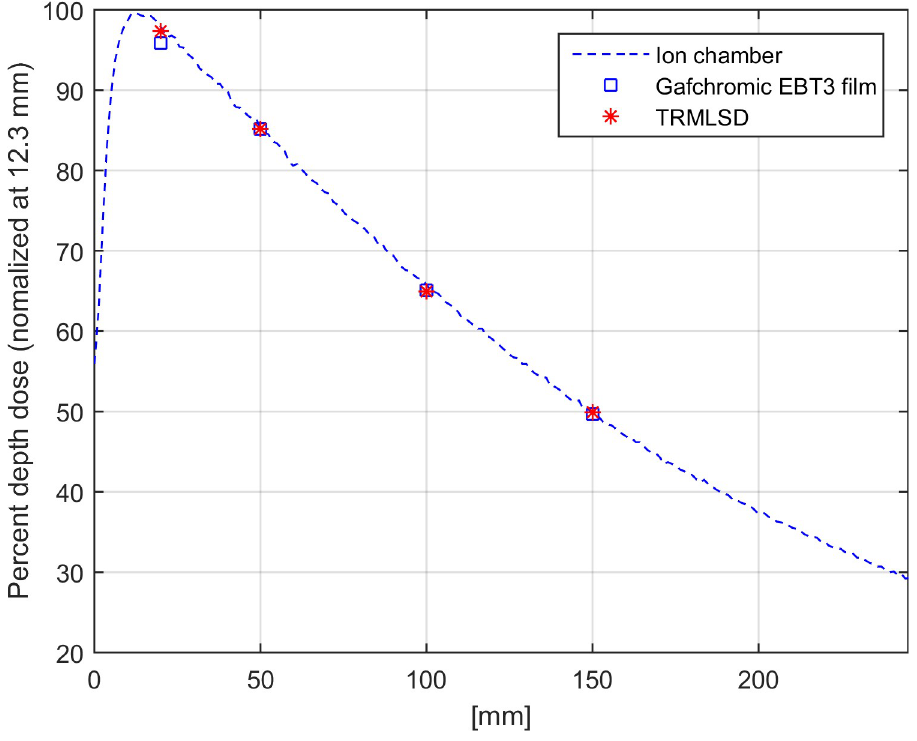
Fig 13. PDD profile measured by the TRMLSD (denoted by stars), EBT3 film (denoted by squares), and ionization chamber (denoted by a dashed line) for a 6 MV X-ray. TRMLSD and EBT3 film data were normalized to the ionization chamber data at a depth of 5.0 cm.